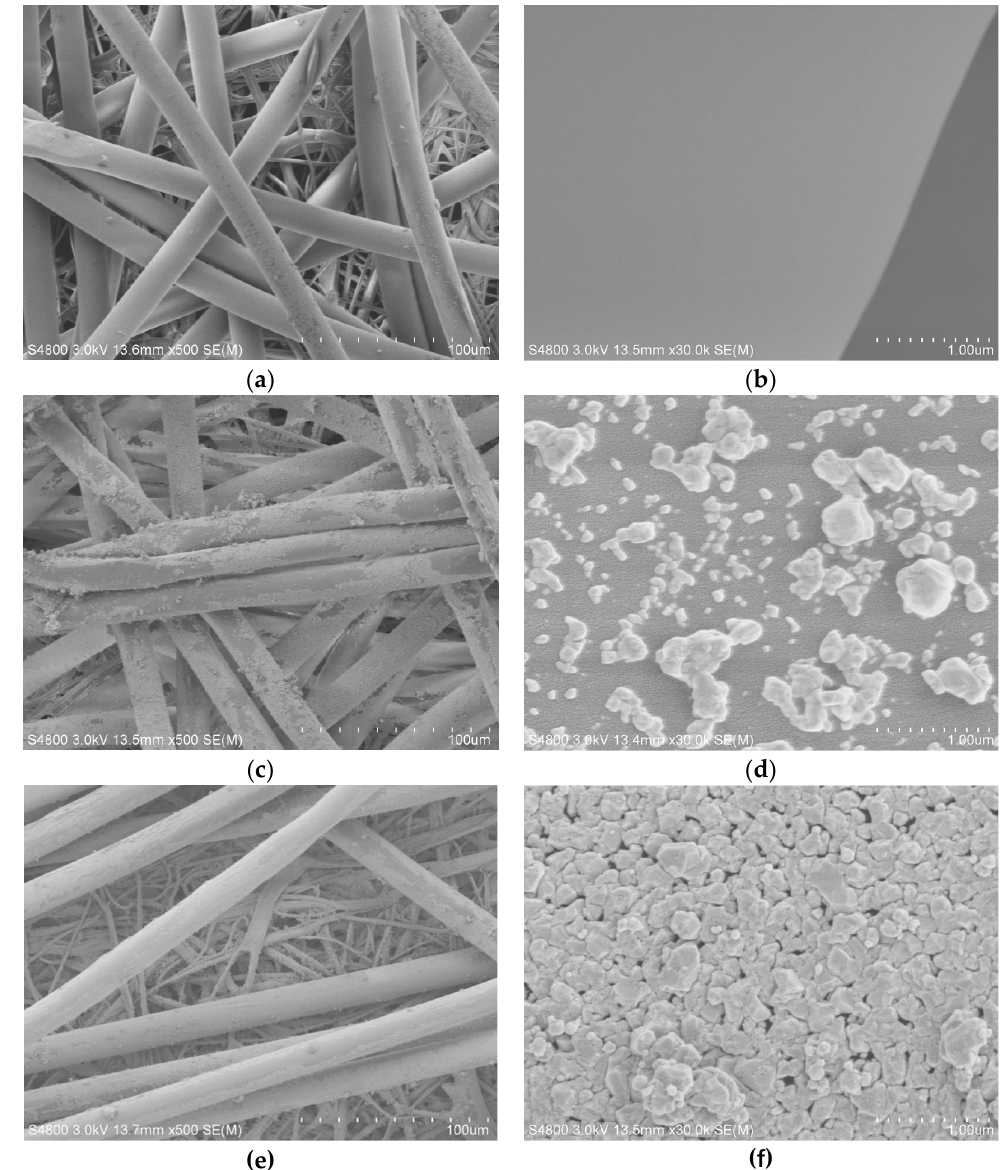
Figure 3. Scanning electron microscopy (SEM) images of ( a , b )nonwoven polypropylene, ( c , d ) treated nonwoven polypropylene (1#), and ( e , f ) treated nonwoven polypropylene (3#).